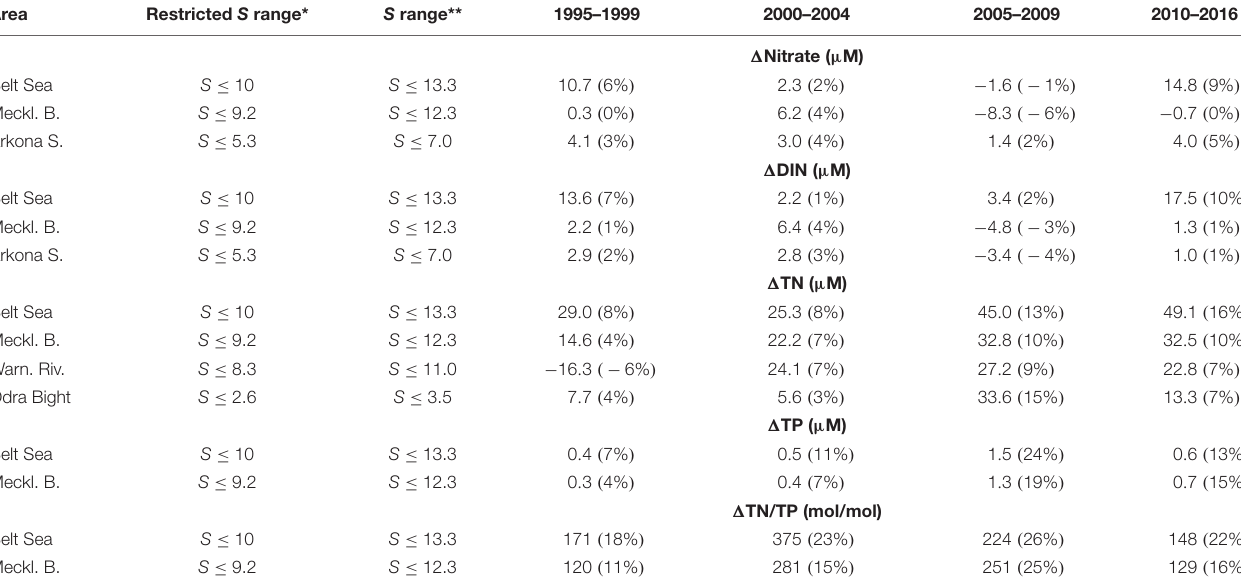
TABLE 2 | Calculated differences of the nutrient concentration end-members ( > 99% significance) of the restricted salinity ( S ) range* and the salinity range until the median; the change is given in% in brackets (see text for further information). Area Restricted S range* S